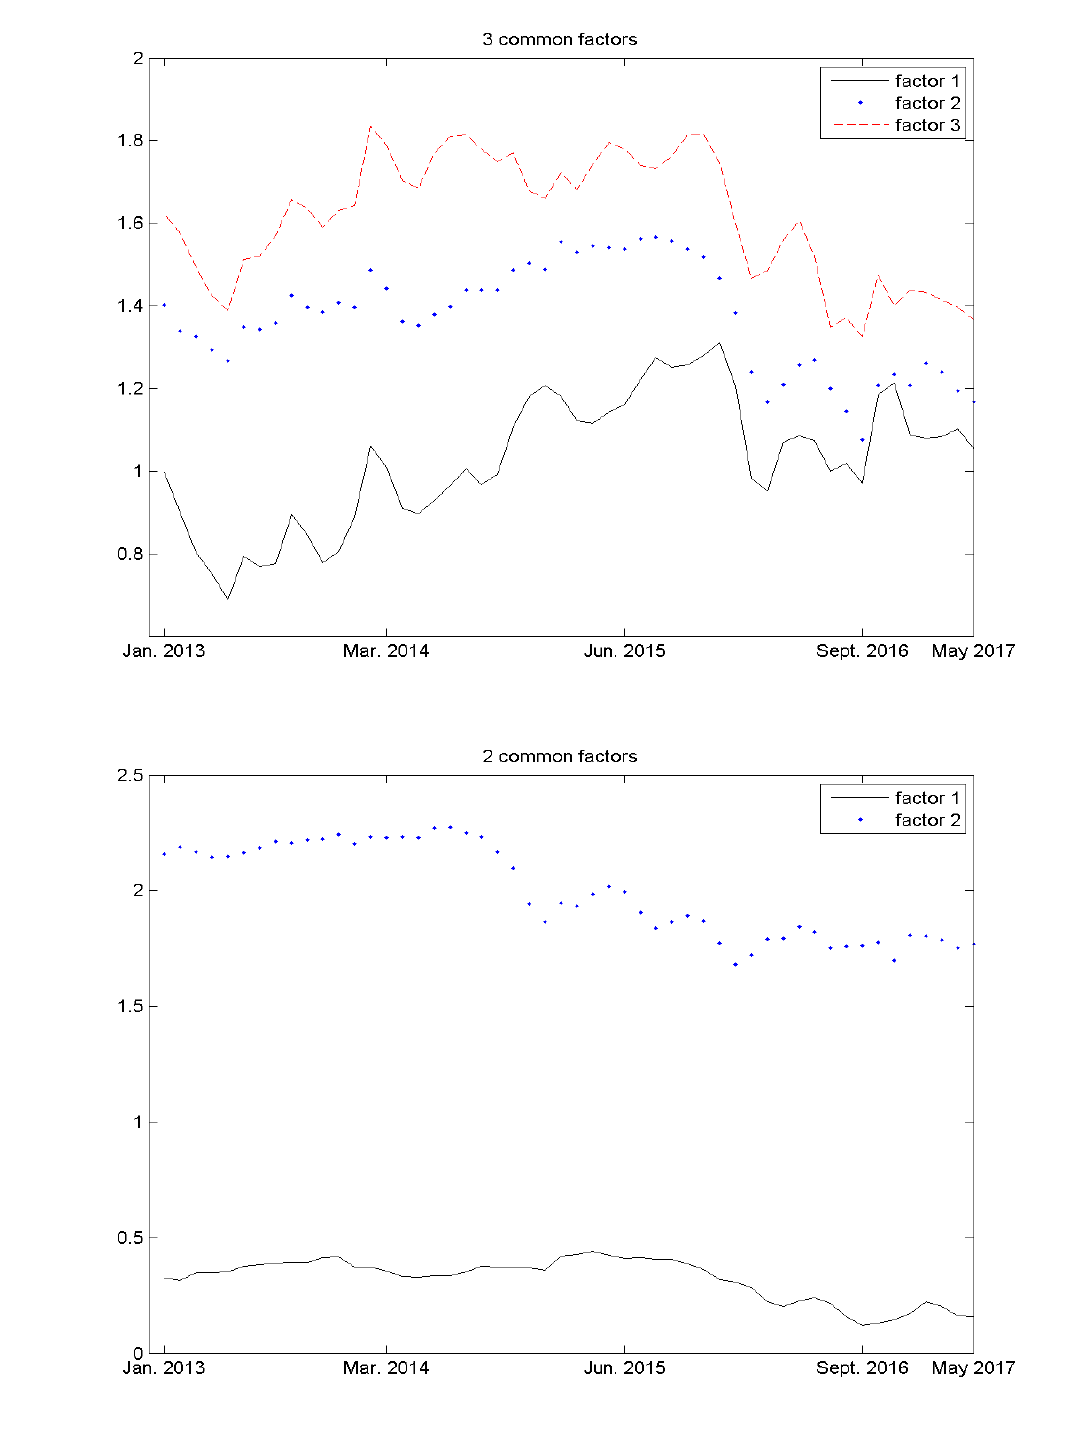
Figure 3. Common trends obtained from the Gonzalo–Granger permanent-transitory decomposition using monthly data from January 2013–May 2017. Top panel for EUA, coal, gas and Brent oil and bottom panel for coal, gas and Brent